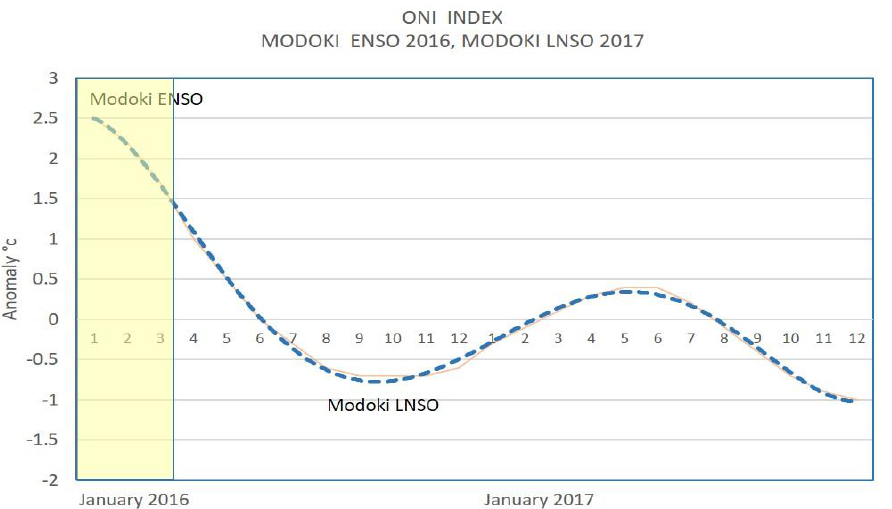
Figure 5. Oceanic ENSO Index ( ONI) values, for the years 2016 and 2017. In the first months of 2016, high values (2.5 °C) were observed, indicating the presence of Modoki ENSO, although it had no incidence in northern Peru. For the first months of 2017, low values were observed, indicating the presence of Modoki LNSO.